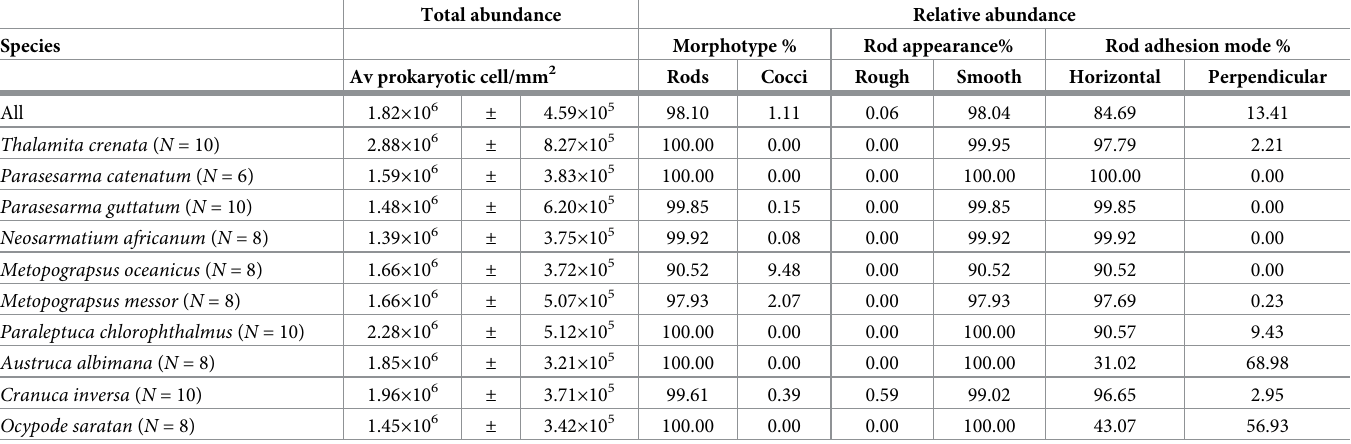
Total abundance of prokaryotic cells for all the species and for each species individually is reported as the average number of cells counted per mm 2 of gill surface ± standard deviation. Relative abundances of different classes of cell morphotypes (rods/cocci), rod appearance (rough/smooth) and rod adhesion mode (horizontal/perpendicular) are reported on the total counts for each class. Number of specimen replicates are shown in the species